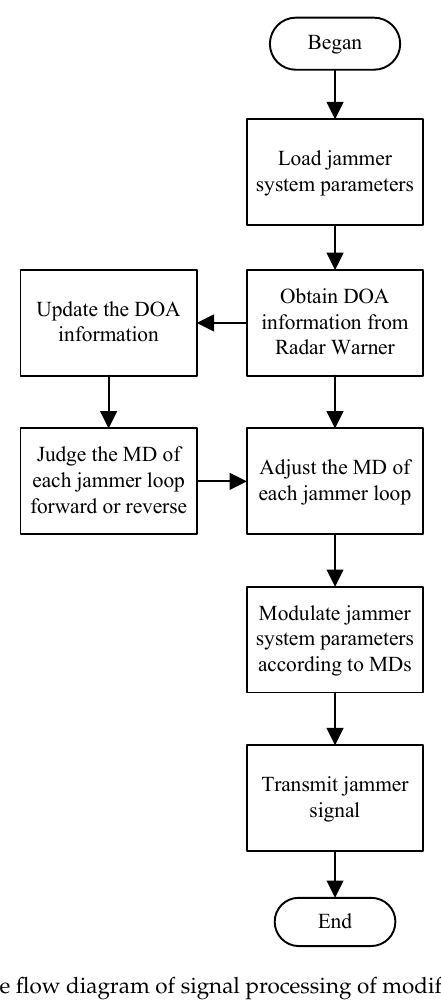
Figure 4. The flow diagram of signal processing of modified C-MRCJ.